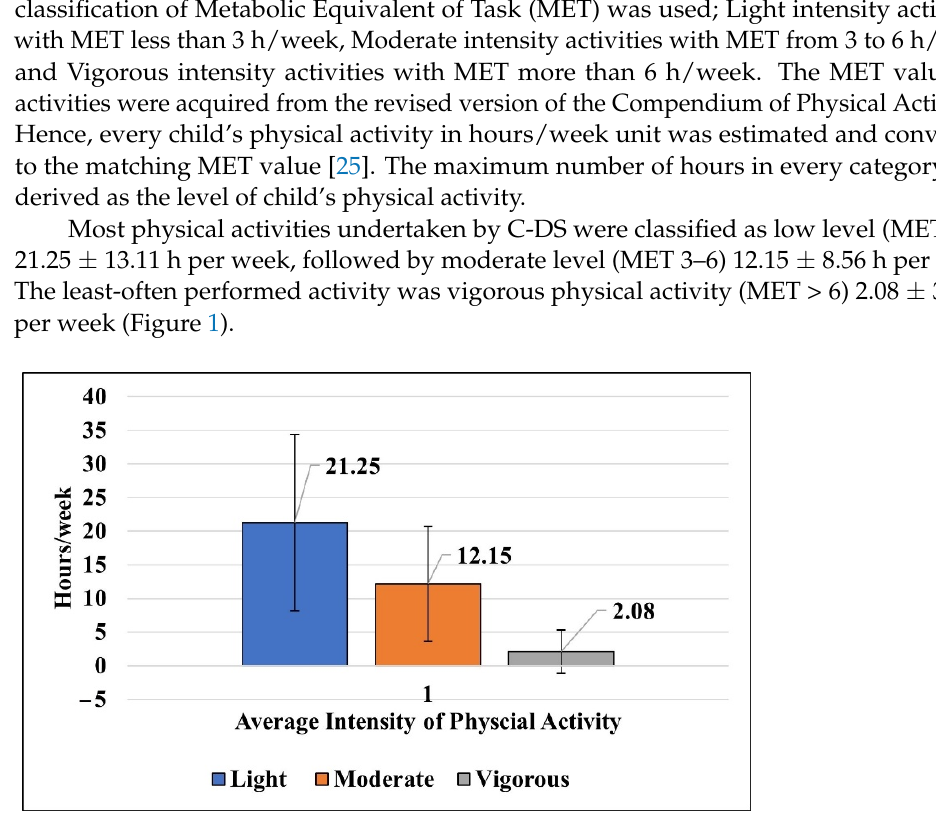
Figure 1. The means of light, moderate and vigorous activity hours for C-DS. 3.7. Relationship between Physical Activity and Gender of the Child with DS The male C-DS (2.35 ± 3.96 h/week) were more likely to practice high level physical activities than female children (1.66 ± 2.29 h/week). On the other hand, female children practiced moderate- (13.41 ± 8.42 h/week) and low-level activities (22.56 ± 12.72 h/week) more than male children (Figure 2). Nevertheless, no significant correlation between gen- der of the child and the level of physical activity was observed ( χ 2 = 0.001, DF = 1, p = 0.97). Figure 2. The means of light, moderate and vigorous activity hours for C-DS according to the child’s gender. 3.8. Relationship between Physical Activity and Technology Use Children who spent ≤ 5 h using technology (2.08 ± 3.24 h/week) performed vigorous activities, whereas children who spent ≥ 6 h using technology did not perform any vigor- ous activities. Similarly, children who were engaged for 5 h or less using technology (21.25 ± 13.11 h/week) performed low levels of physical activities more than children who spent 6 h or more using technology (13.85 ± 11.52 h/week). Contrastingly, children who spent 5 h or less using technology (12.15 ± 8.56 h/week) performed moderate level of activities less than the children who spent ≥ 6 h using technology (16.75 ± 1.76 h/week) (Figure 3).